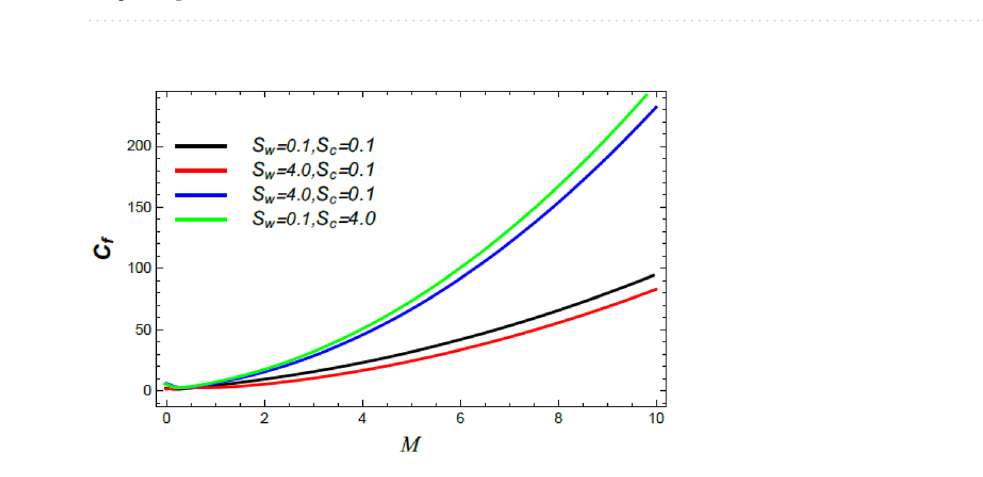
Figure 26. Skin friction coefficient versus M as given in Eq. (36) to depict the effect of the Stefan blowing parameter S w and Schmidt number S c